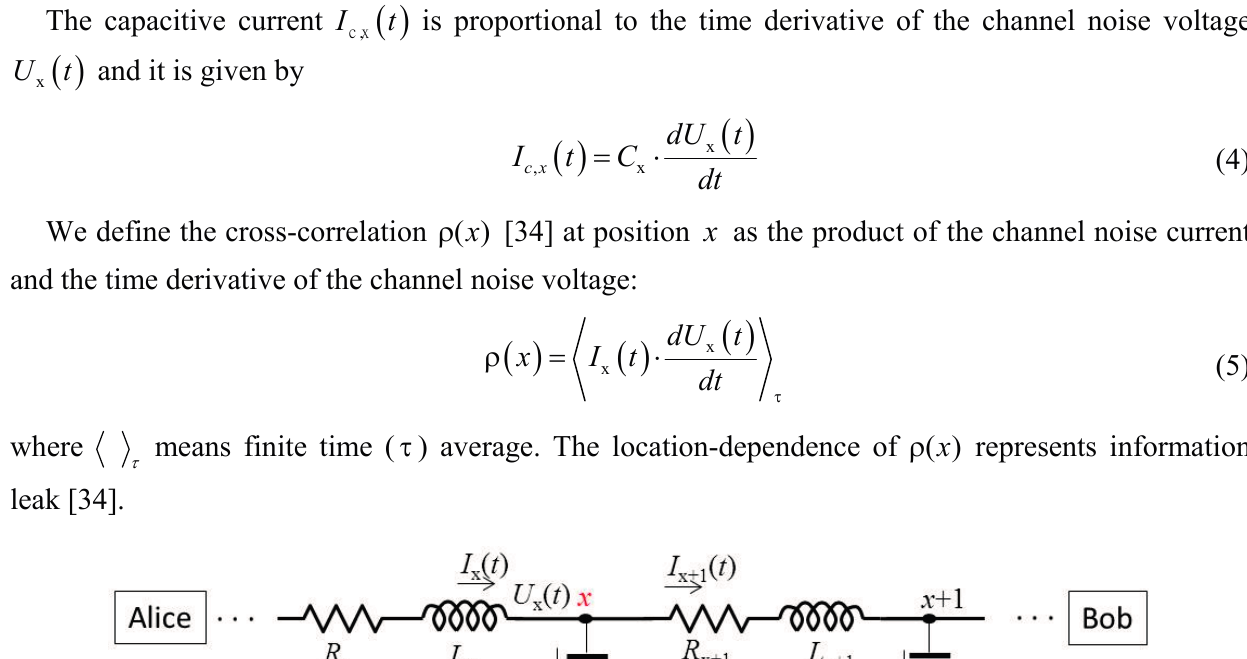
Figure 2. Cable model and cable capacitive currents.